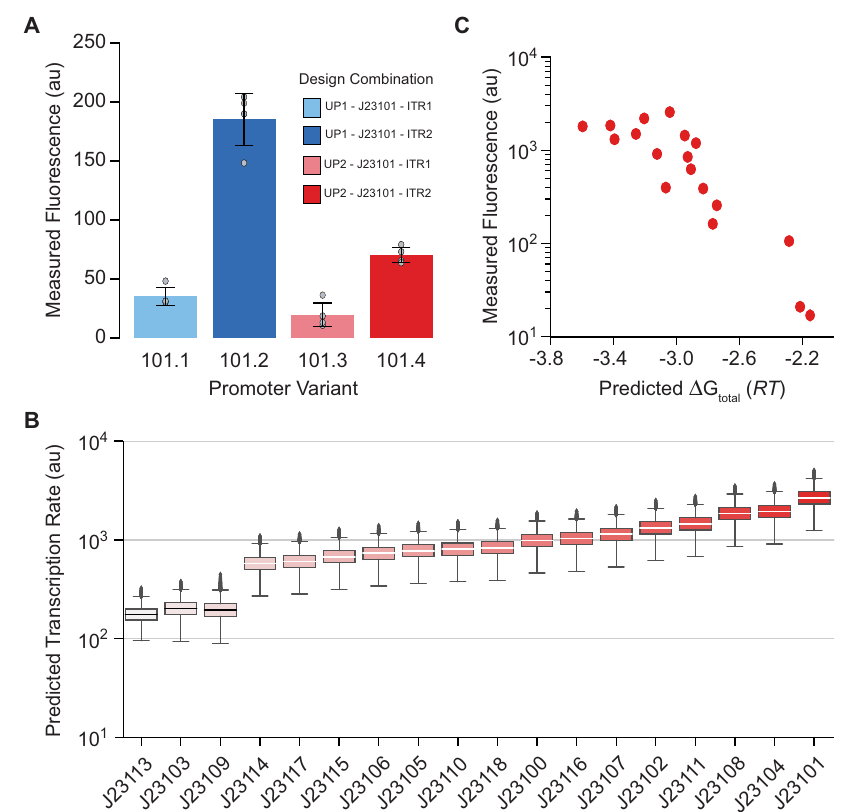
Fig. 4 | Promoter Context Effects. A Measured in vivo transcription rates for the J23101 promoter genetic part with varied upstream (UP) and downstream (ITR) sequences, showing transcriptionalcontexteffects.Graydotsdenoteindependent measurements ( n =4 biological replicates). Bars denote each variants measured mean±standard deviation. B Transcriptional context effects are quanti fi ed for common promoter genetic parts, showing predicted transcription rates when varying 30bp of the upstream and downstream sequences. Distributions were